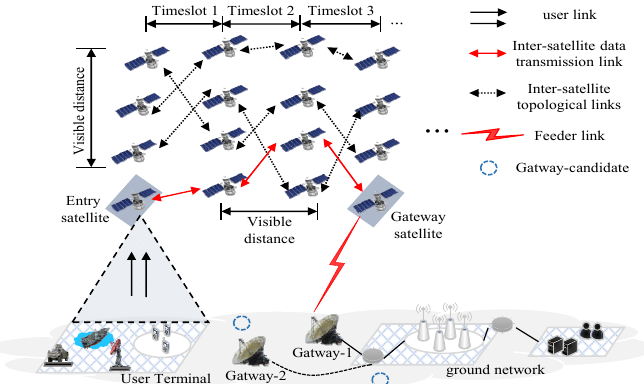
Figure 1. Task transmission process of low-orbit constellation network.